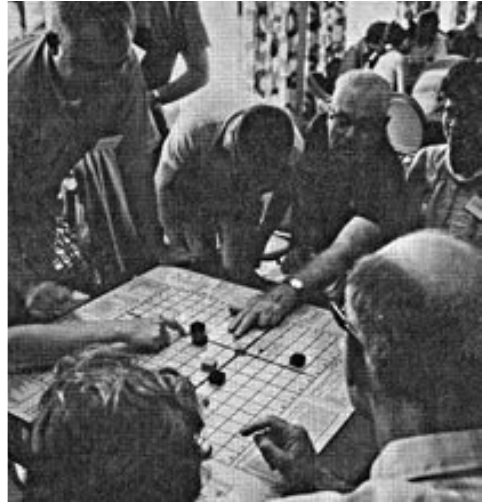
Figure 2. A group playing CLUG. Source: Feldt (2014, p. 291).